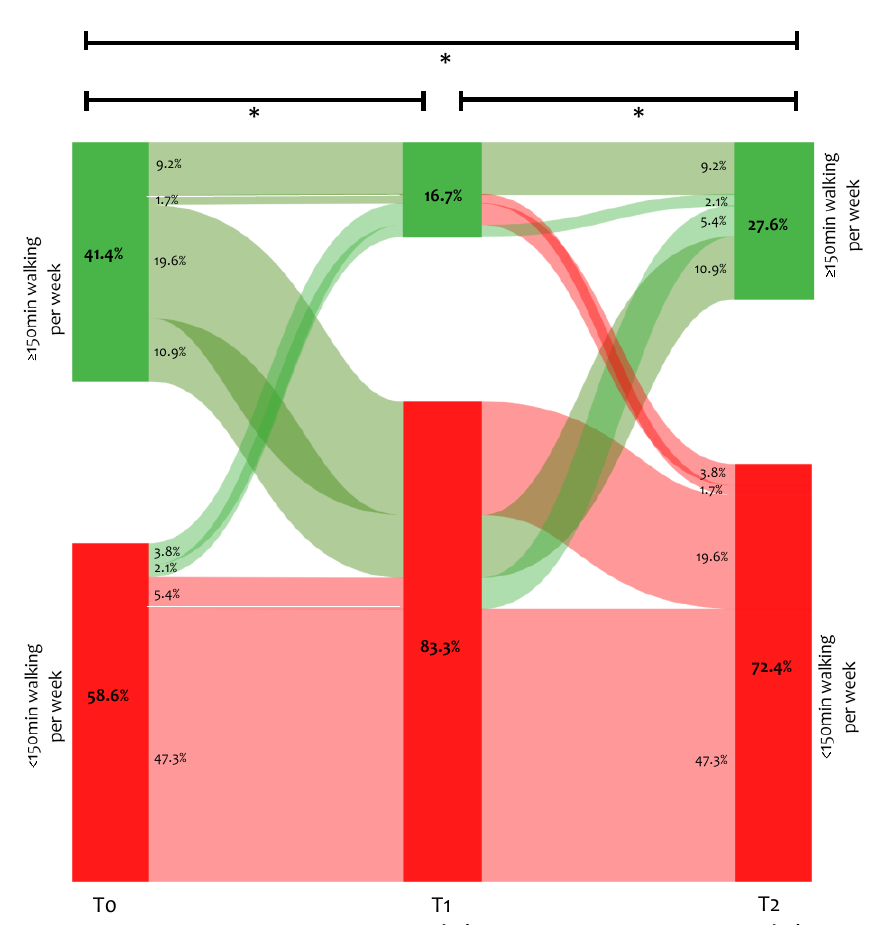
Figure 2. Proportion of participants divided based on achieving 150 min. walking per week before (T0) and at 3 months (T1) and 6 months (T2) of follow-up; * significant difference p < 0.05.